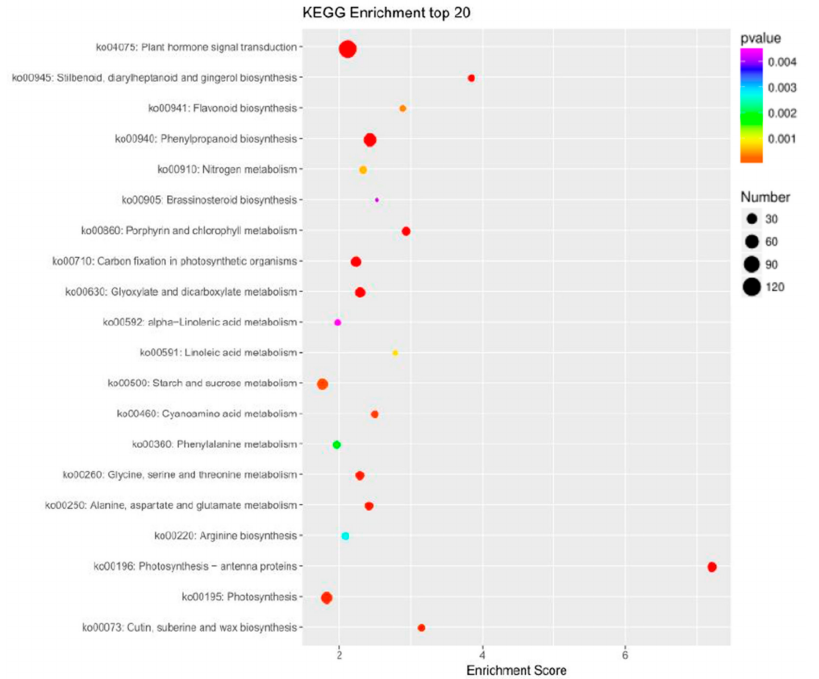
Figure 6. Kyoto Encyclopedia of Genes and Genomes (KEGG) pathway scatterplot of 871 di ff erentially expressed genes (DGEs). The x-axes indicate enrichment score. The bigger the bubble, the more the DGEs. The smaller the p-value, the more significant the KEGG enrichment.